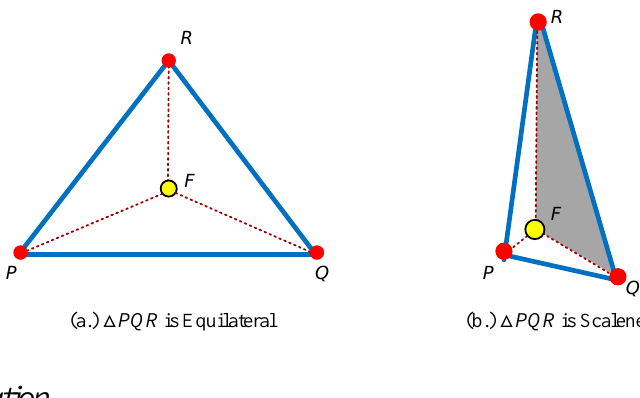
Figure 8. Types of  PQR